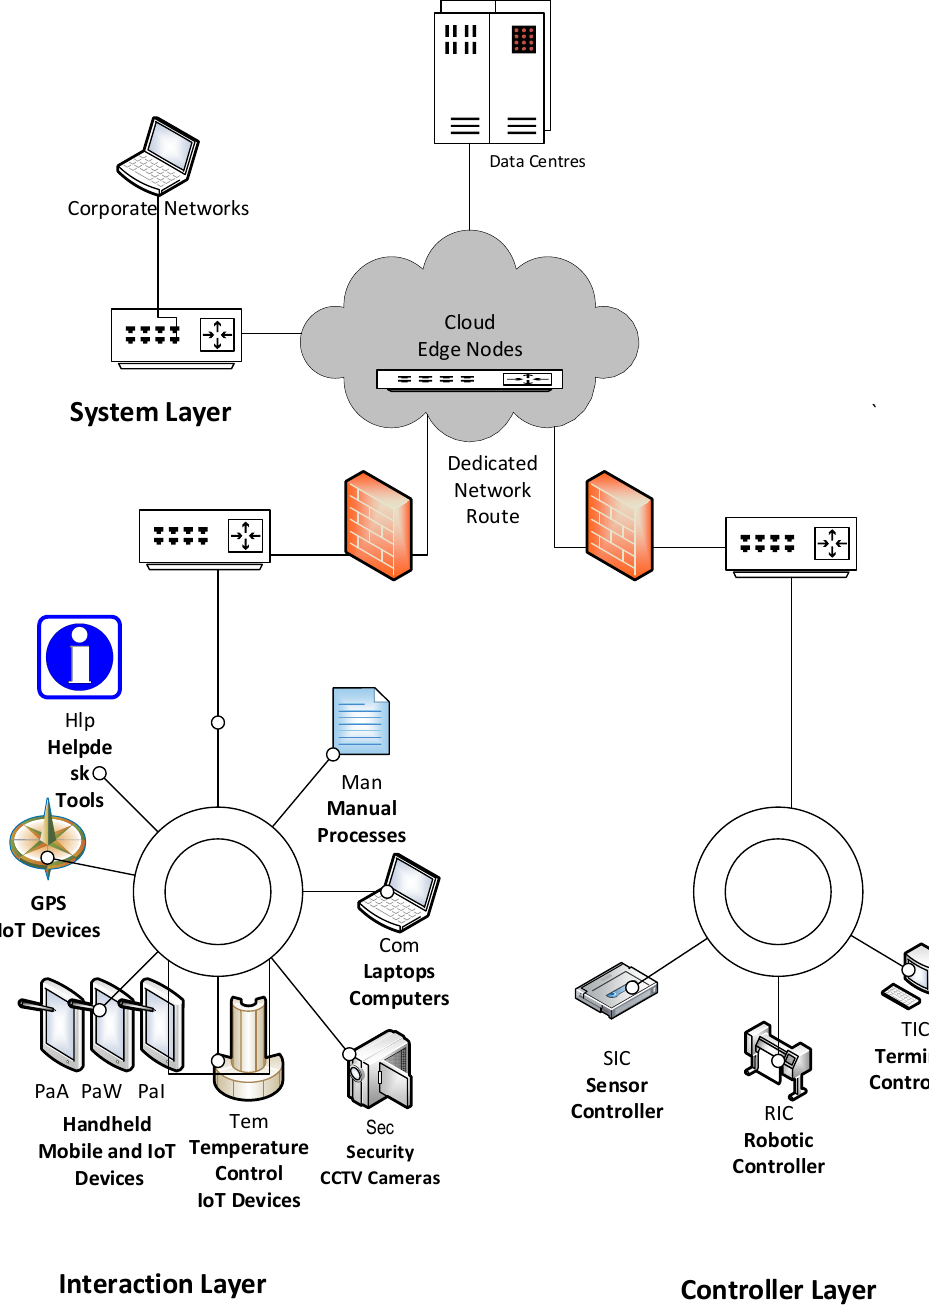
Figure 8. Hybrid network topology for case study 2.